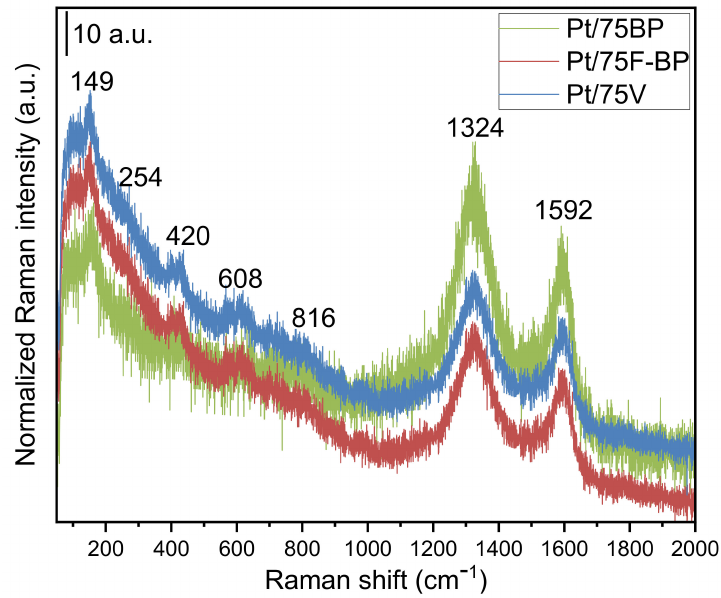
Figure 5. Raman spectra of the Pt/75BP, Pt/75F-BP and Pt/75V